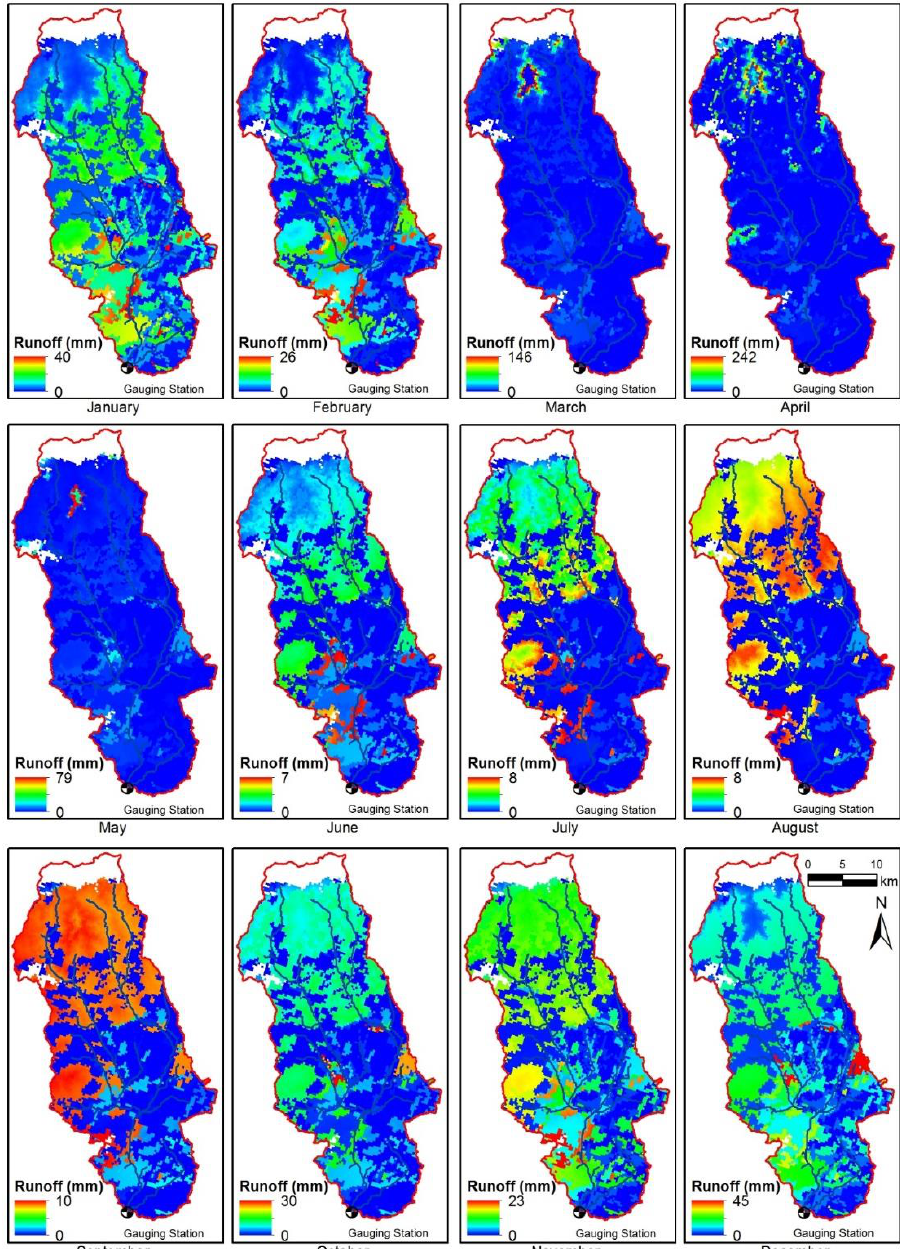
Figure 9. Monthly runoff map derived from the PESERA